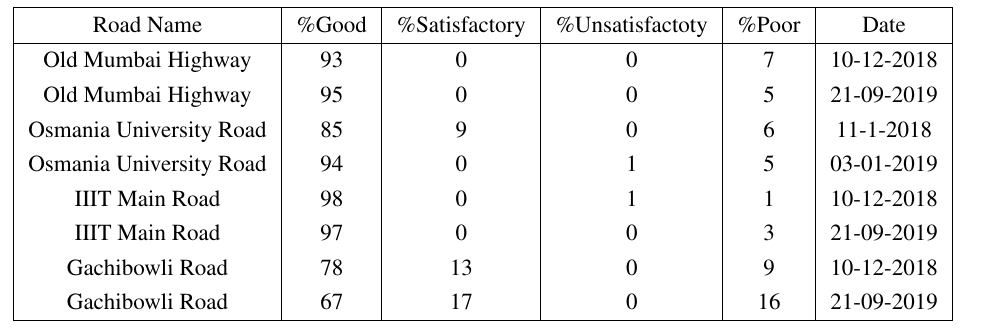
Table 2. Current state of roads in Hyderabad city